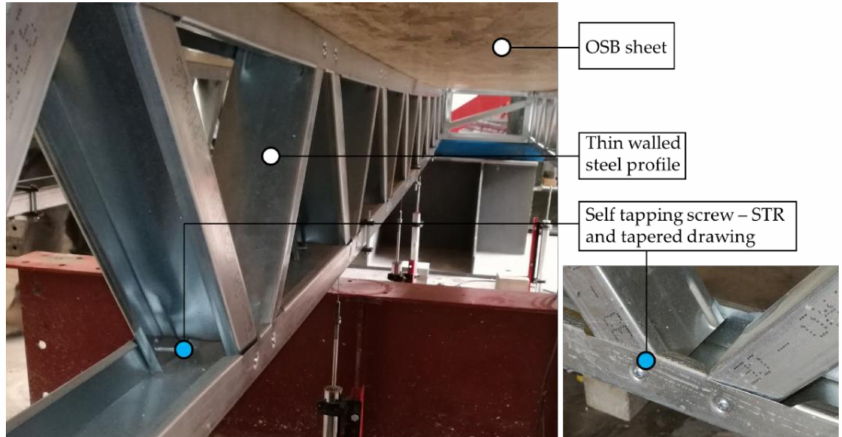
Figure 3. Detail of a floor truss system with the 5 m opening gravitationally